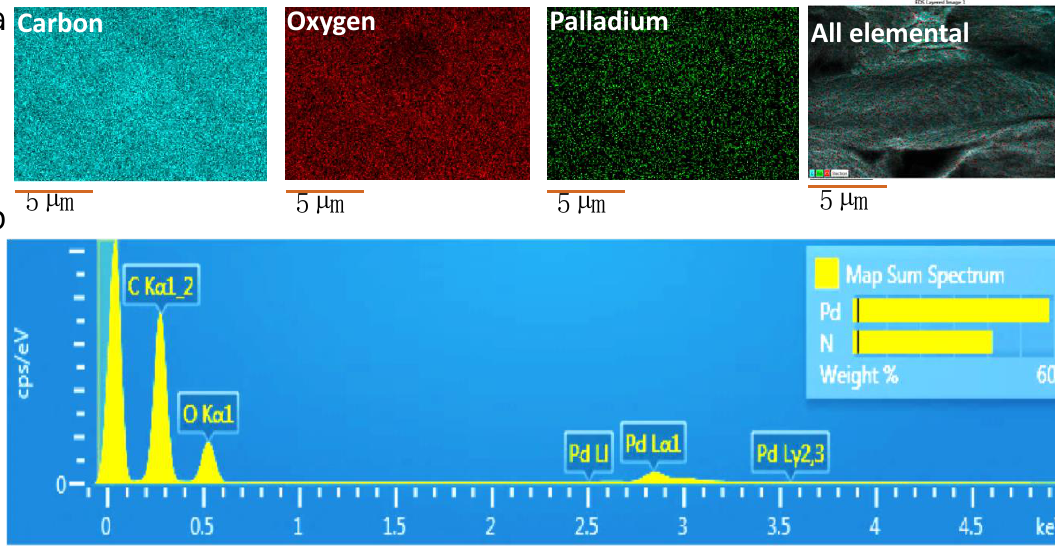
Figure 5. SEM-EDS elemental mapping of MPR110-EW-P3 where (a) analogous elemental mapping of the element Carbon, Oxygen, Palladium and all, scale bar 5µm (b) Area EDS spectrum for table 2 for the atomic and weight percentage of various elements Table2. Carbon, Oxygen, Nitrogen and Palladium in various Pd-MRs catalyst based on EDS